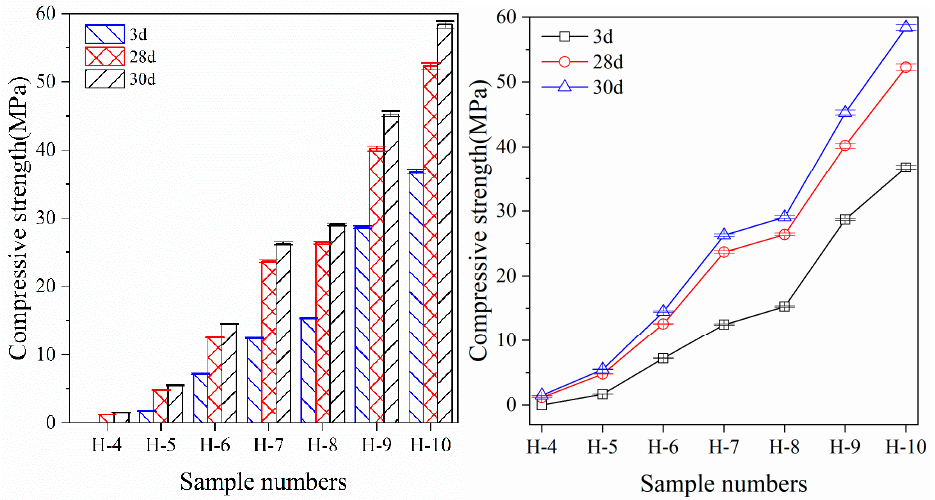
Figure 1. Compressive strength of the polymer samples.